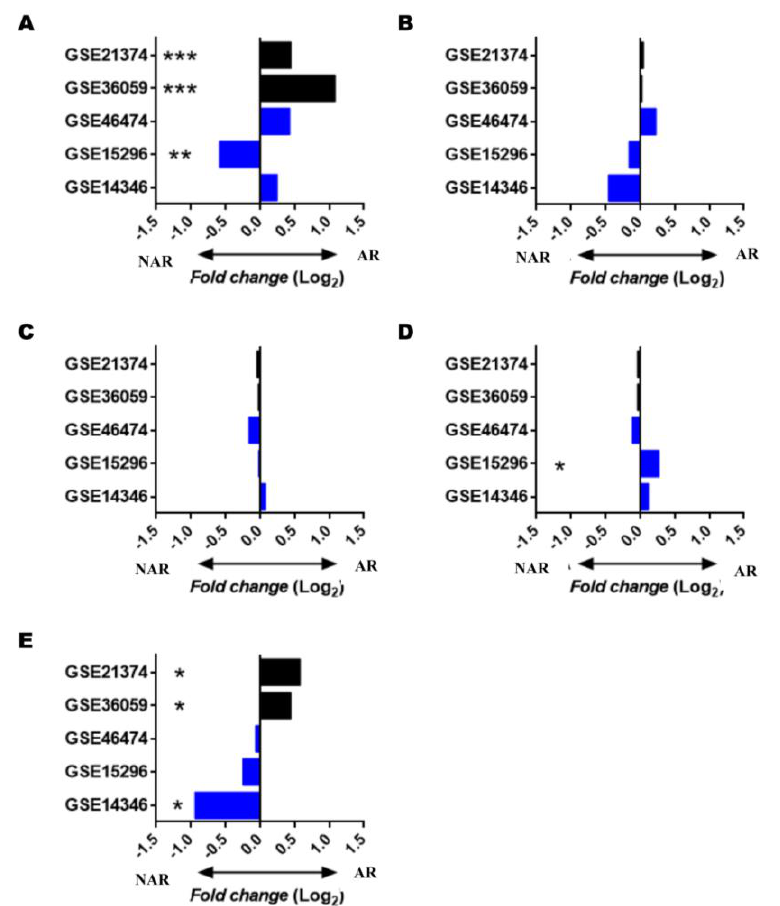
Figure 5. Gene expression of BAFF, APRIL, and their receptors (R-BAFF, TACI, and BCMA) from selected GEO studies. Figures represent the ratio of gene expression (fold change) of BAFF ( A ), APRIL ( B ), R-BAFF ( C ), TACI ( D ), and BCMA ( E ) among KTRs of NAR and AR groups in studies performed in peripheral blood (blue bars) and biopsy samples (black bars). The sample sizes of each analyzed cohort and the number of patients with AR and NAR are shown in Table 1. Positive values indicate increased expression in KTRs from the AR group, and negative values increase in KTRs from the NAR group. AR, acute rejection; NAR, non-acute rejection. p values were adjusted by the FDR method. FDR values < 0.05 were considered significant. * FDR < 0.05; ** FDR < 0.01; *** FDR <